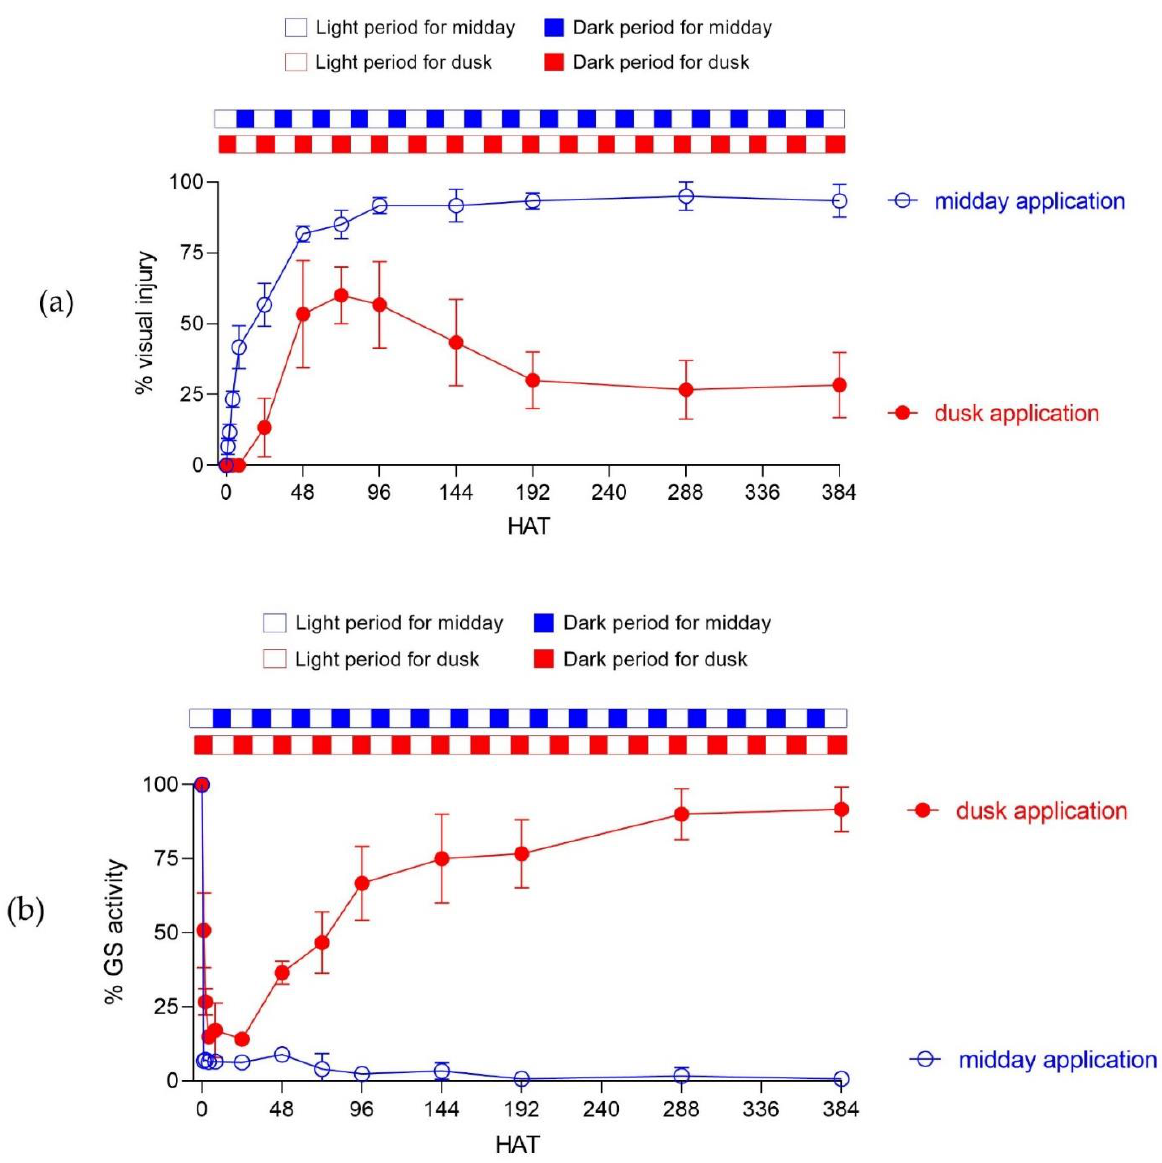
Figure 4. Turnover of glutamine synthetase (GS) total activity only occurs when glufosinate is applied at midday. Percent visual injury ( a ) and GS activity ( b ) after glufosinate application at midday (full red circle) or dusk (empty blue circle). Full squares represent daily photoperiod time for each application time (midday in blue, dusk in red). Dark periods are full squares whereas light periods are open squares.